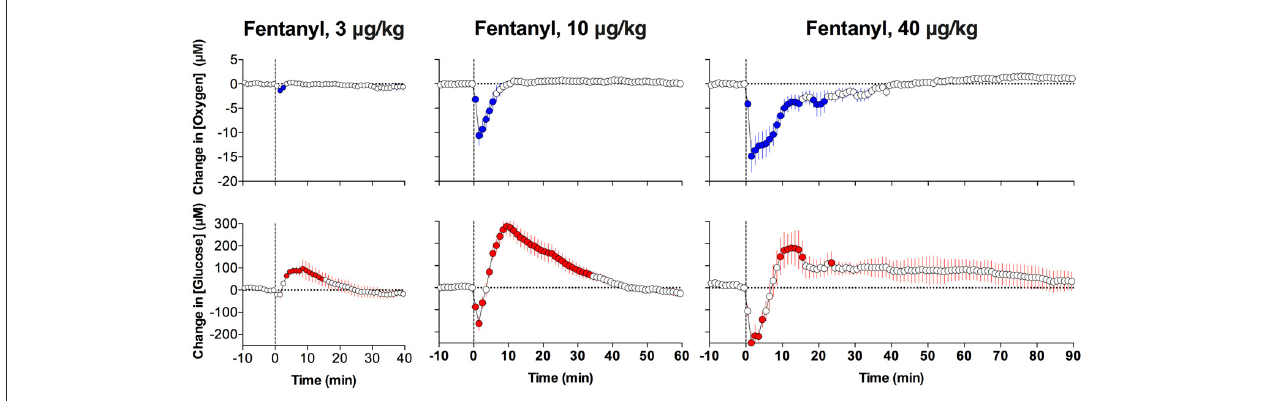
FIGURE 7 | Mean ( ± SEM) changes in NAc oxygen (top graphs) and glucose (bottom graphs) concentrations induced by intravenous fentanyl injections at different doses. Data were analyzed with slow, 1-min time resolution. Vertical hatched lines show onset of injection. Original data were published in Solis et al. (2018b).